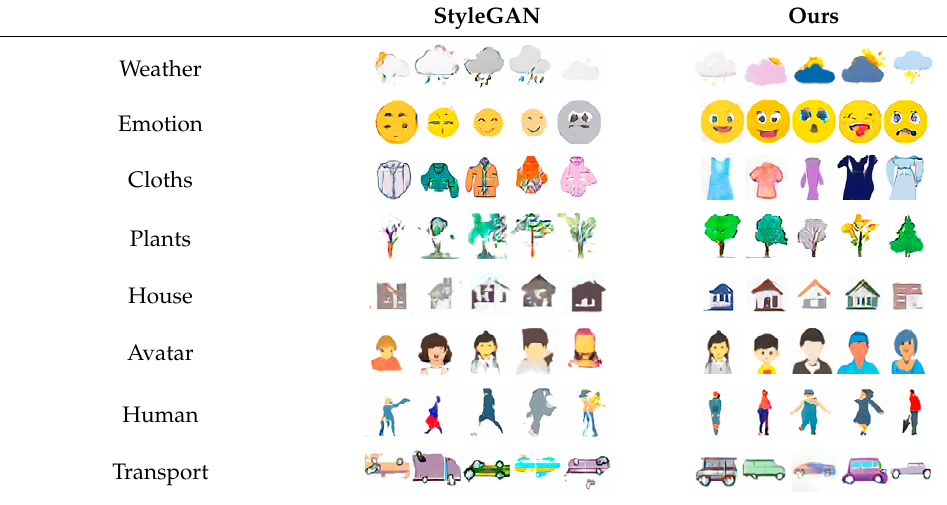
Table 1. Comparison between StyleGAN and ours model generated results.